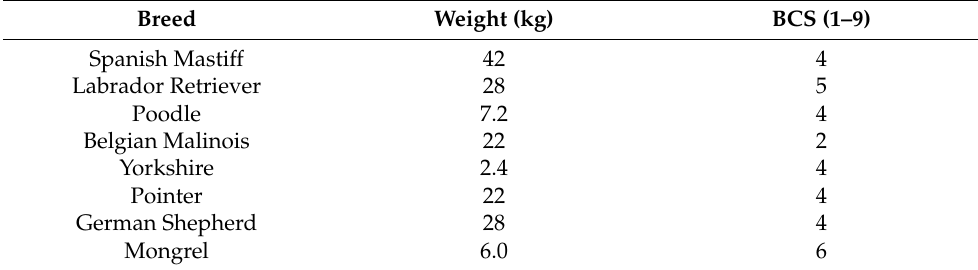
Table 1. Demographic distribution of the animals. BCS, body condition score. Breed Weight (kg) BCS